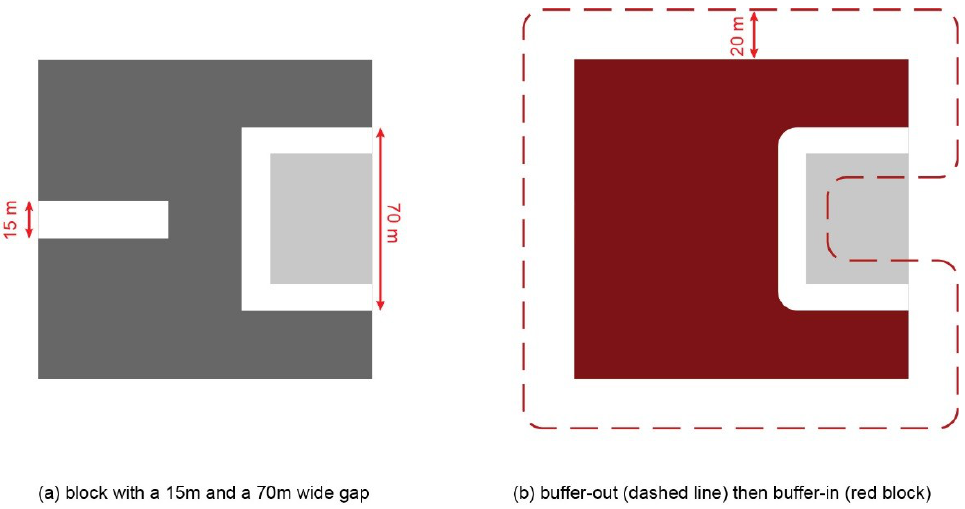
Figure 2. Example of dead-end removal.